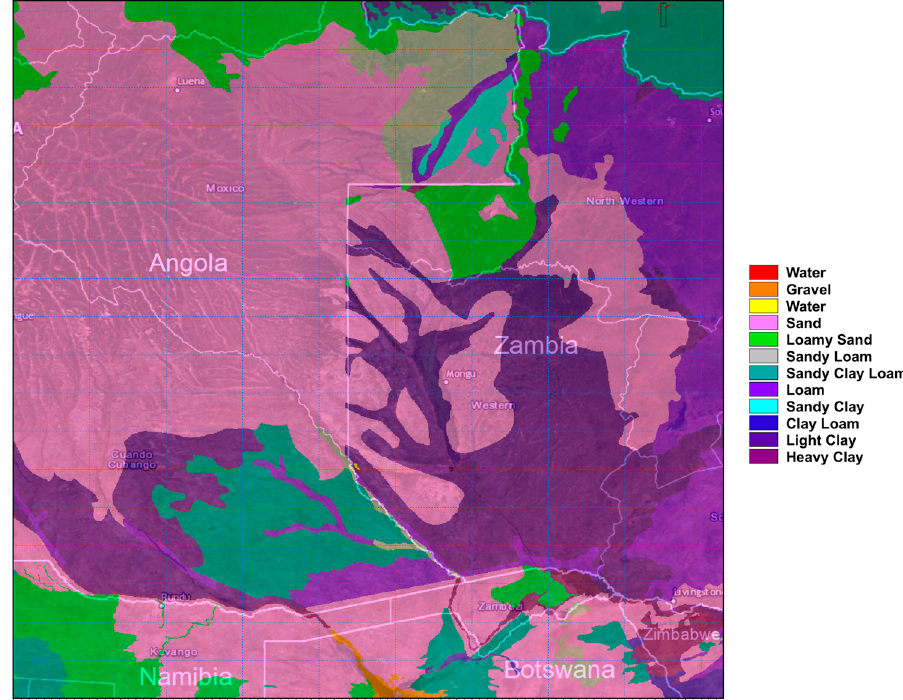
Figure 15. Screenshot of the MIKE SHE soil type input grid of the Upper Zambezi River Basin extracted using the Large Basin Data Portal tools from the FAO HWSD dataset.